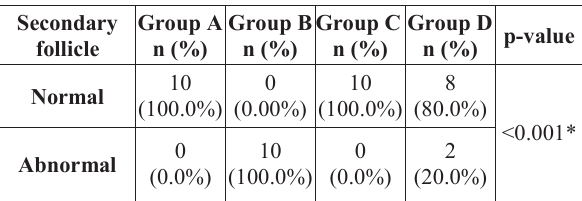
Table-1: Distribution of appearance of Secondary follicle among control & experimental groups. Based on Fisher’s exact test